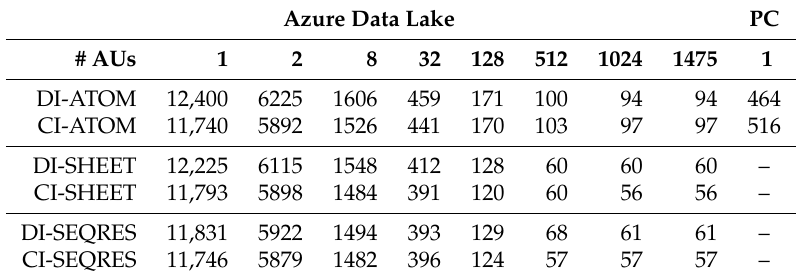
Table 1. Execution time (s) for local (PC) and distributed (Azure Data Lake) extractions of various sections of the PDB files and the varying number of allocation units (AUs) for 3D protein structures stored separately as compressed (CI) and decompressed (DI) individual